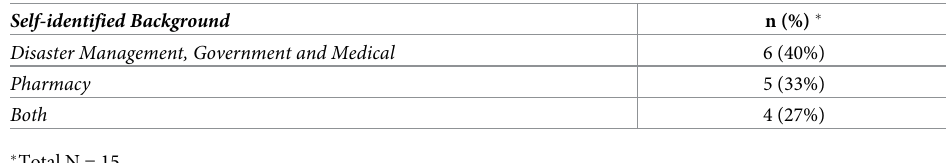
Table 1. Delphi study expert panel